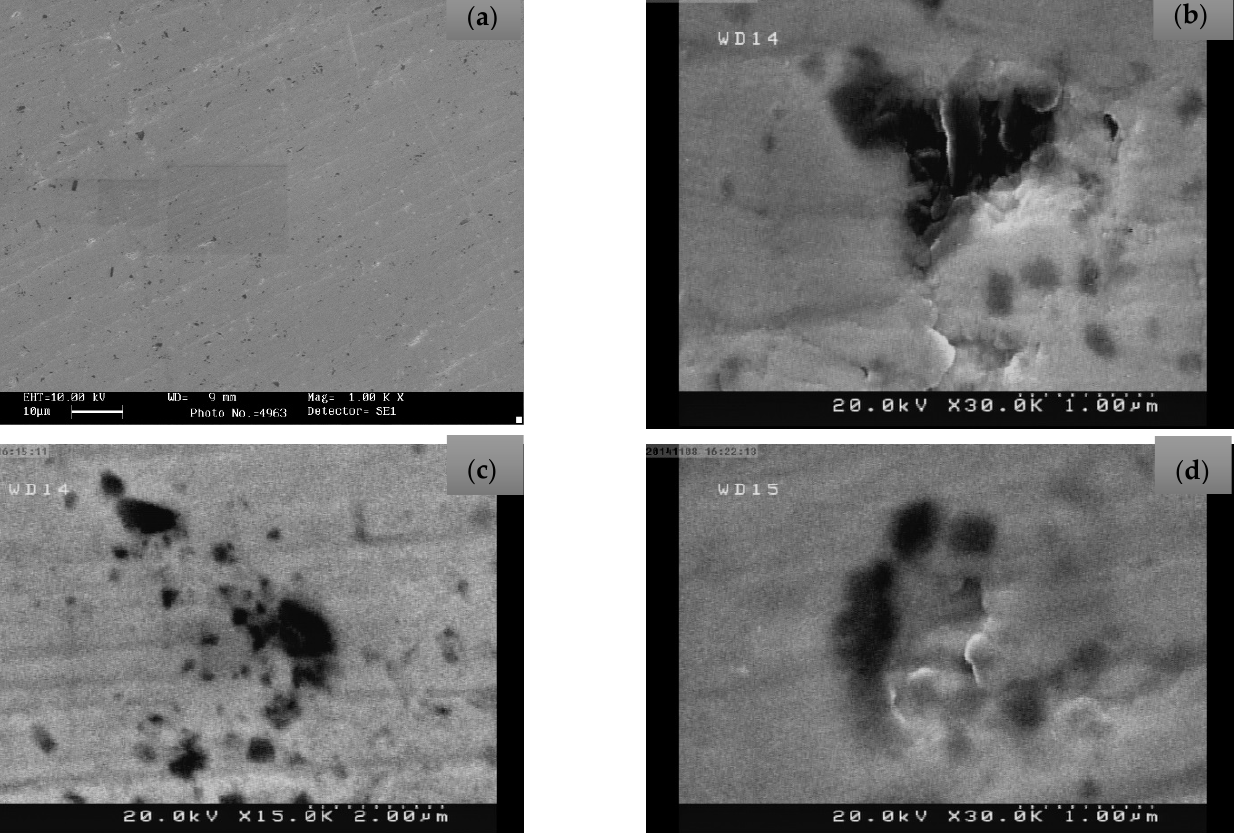
Figure 3. Scanning electron microscopic (SEM) images of ( a ) unimplanted in comparison to implanted samples after corrosion test with argon dose of ( b ) 1 × 10 17 ions/cm 2 , ( c ) 3 × 10 17 ions/cm 2 , and ( d ) 7 × 10 17 ions/cm 2 .